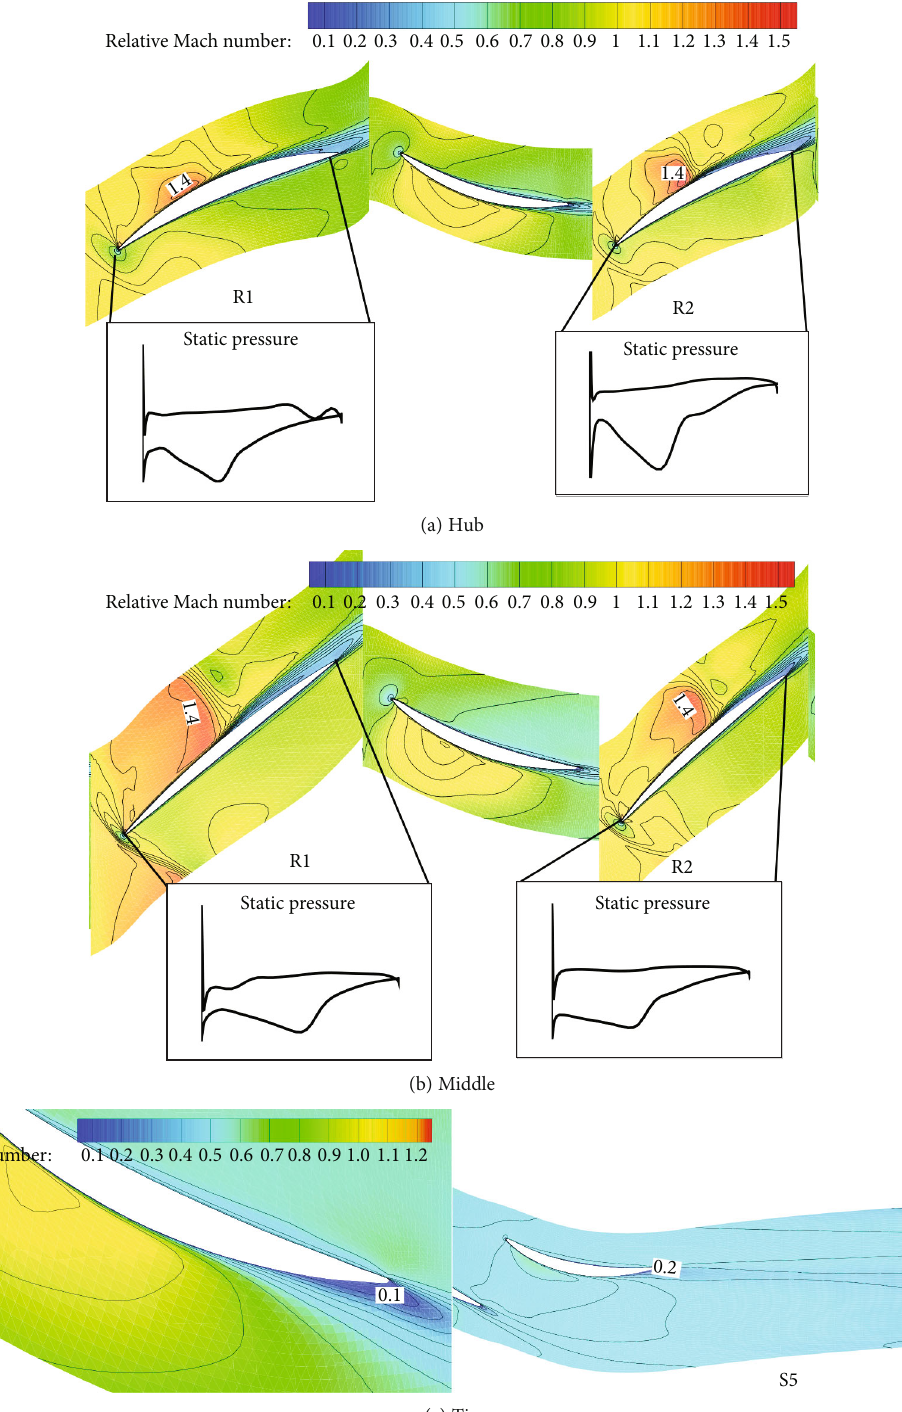
Figure 11: Static pressure and Mach number distribution at the hub, middle, and tip sections in the fi rst (2) Optimization Parameter Settings in the Second Phase . variables of the second phase. The rest of the blade row is fi xed to the optimized blade obtained in the fi rst phase. After the fl ow fi eld calculation and analysis of the optimized geometry obtained in the fi rst phase, a total of fi ve rows of blade geometry of R1, R2, R3, S1, and S5 are selected as opti- The optimization objectives, conditions, and constraints mized in the second phase. To reduce the optimization of the second phase are the same as those in the fi rst phase.